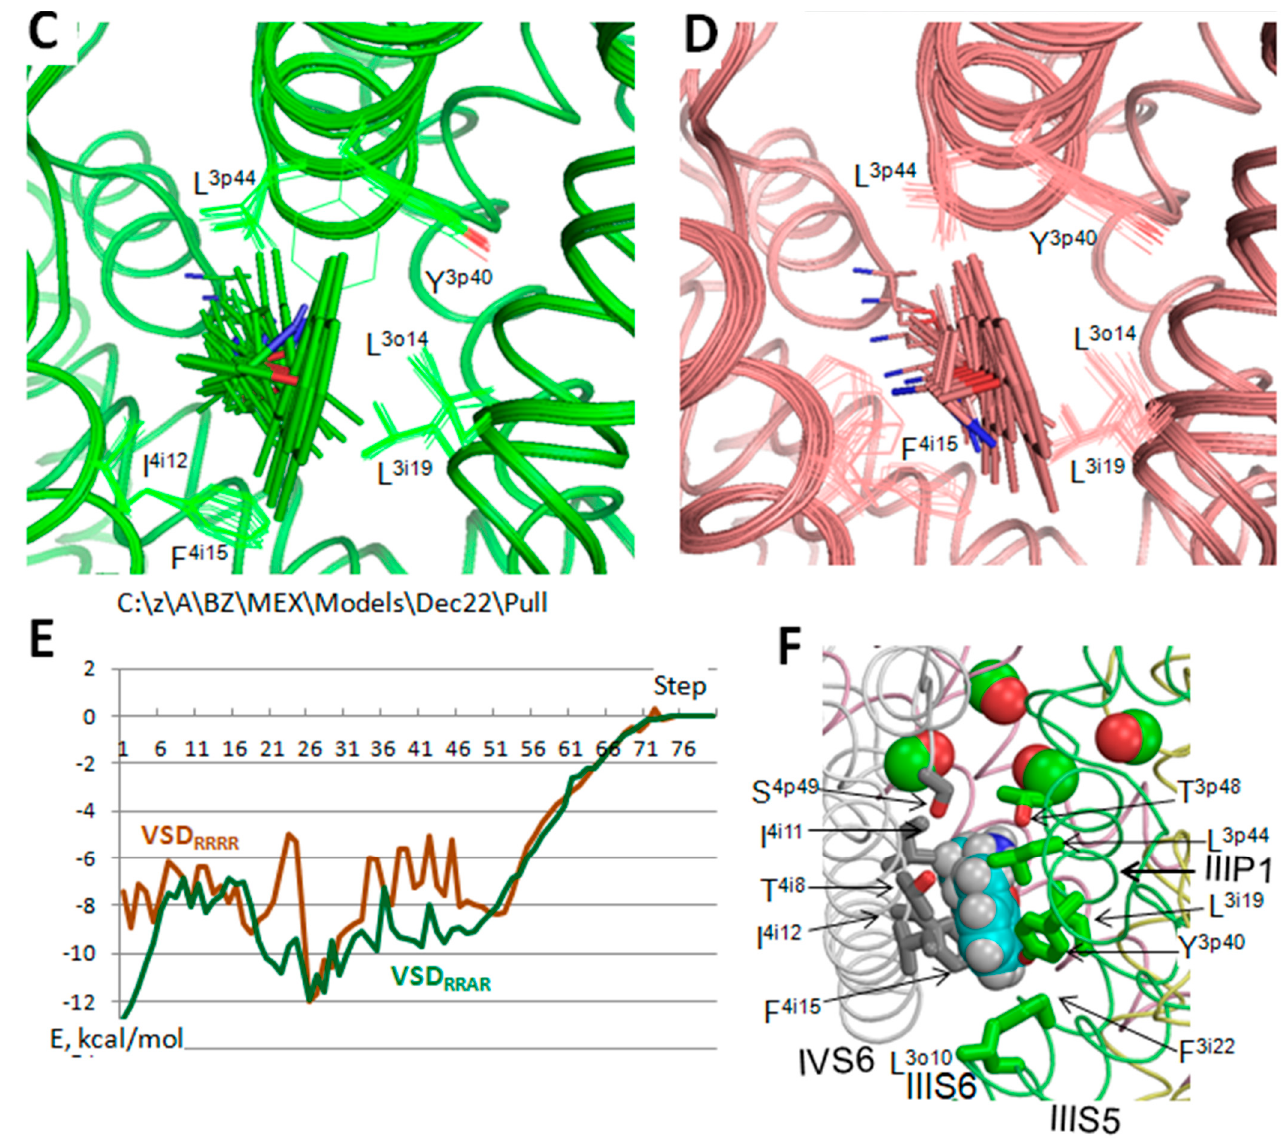
Figure 6. MEX in the III/IV fenestration of hNav1.5. ( A ) Superposition of 80 positions of MEX in model VSD RRRR with four deactivated VSDs (brown) and model VSD RRAR with activated VSD III and three deactivated VSDs (green). The starting position of MEX corresponds to the TB binding pose. Subsequent positions were generated by pulling p -carbon of MEX away the pore axis with the step of 0.4 Å. At each step, two MC-minimizations were computed staring from the structure found in the previous step. During the first MCM, backbones were fixed, the p –carbon was restrained at the given distance from the pore axis, and all other degrees of freedom were allowed to vary. In the second MCM, no constraints were imposed. Each MCM trajectory was terminated when the last 100 energy minimizations did not decrease the energy of the apparent global minim found at the given step. ( B ) Expanded view of fenestration III/IV along helix P1 III . Note that in model VSD RRRR fenestration III/IV is narrower than in model VSD RRAR . ( C , D ) Expanded intra-membrane views of MEX in fenestration III/IV. Side chains of residues whose conformations change with moving MEX are shown by lines. ( E ) Energy of MEX interaction with the channel plotted against the step number. Note that energy of the TB binding pose of MEX in model VSD RRAR is lower than in model VSD RRRR R. ( F ) MEX in model VSD RRAR at step 27, which corresponds to the local energy minimum. Side chains of residues within 4 Å from MEX are shown as sticks. MEX and the pore-facing backbone carbonyls in positions p48 are shown by